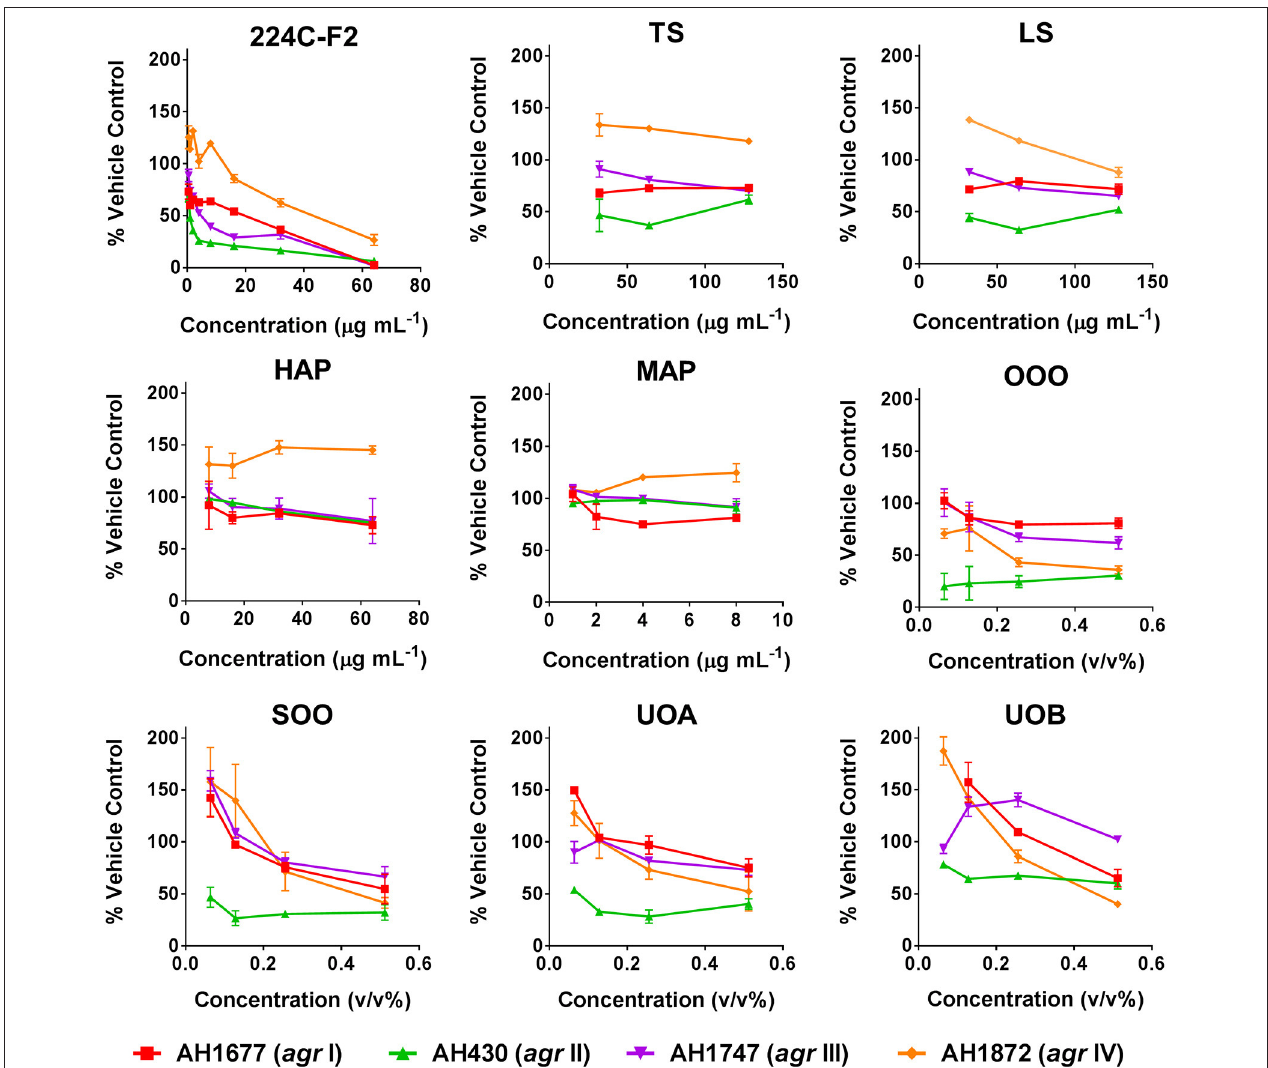
FIGURE 6 | Impact of H. perforatum extracts on S. aureus quorum sensing, as detected by agr reporters. Activity was detected by measure of fluorescence and is reported as percent of the vehicle control. The botanical extract “224C-F2” (a known quorum quencher) was used as the positive control ( Quave et al., 2015).